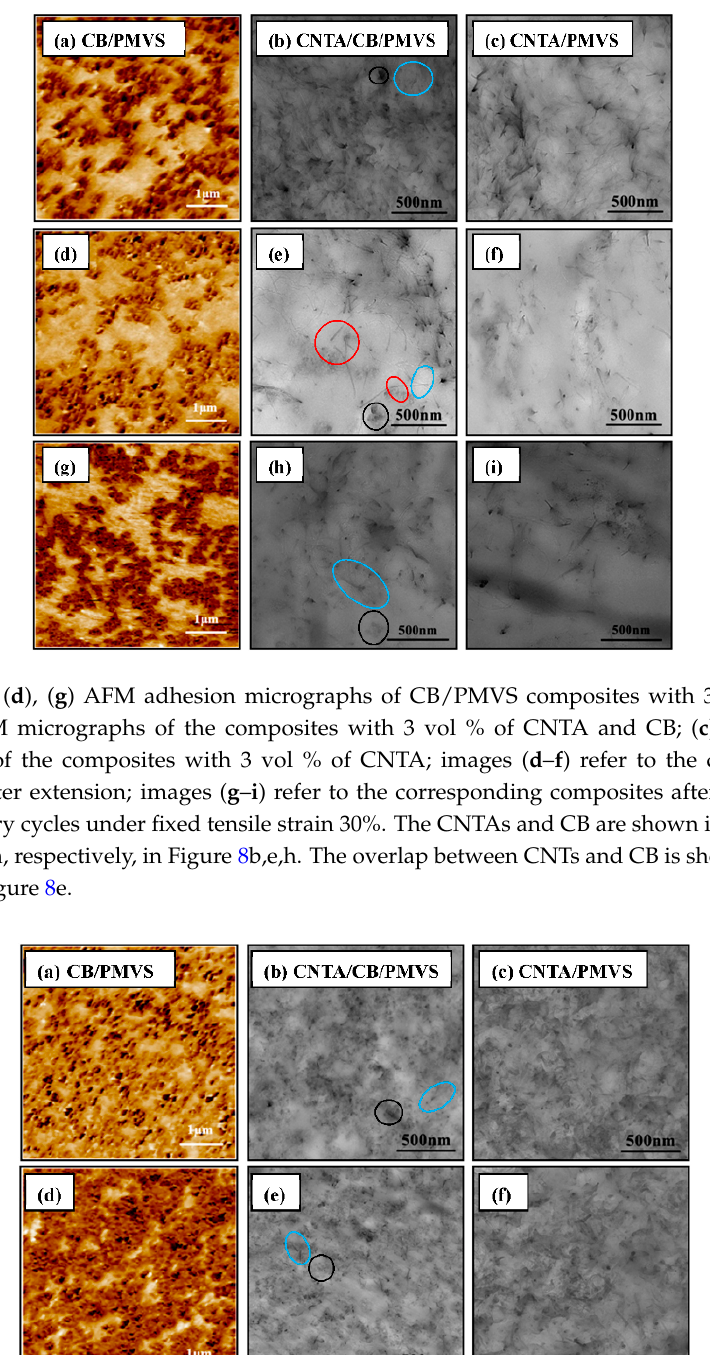
Figure 9. ( a ), ( d ) AFM adhesion micrographs of CB/PMVS composites with 6 vol % of CB; ( b ), ( e ) TEM micrographs of the composites with 6 vol % of CNTA and CB; ( c ), ( f ) TEM micrographs of the composites with 6 vol % of CNTA; images ( d – f ) refer to the corresponding composites after extension. The CNTAs and CB are shown in the blue and black oval area, respectively, in Figure 9b,e.